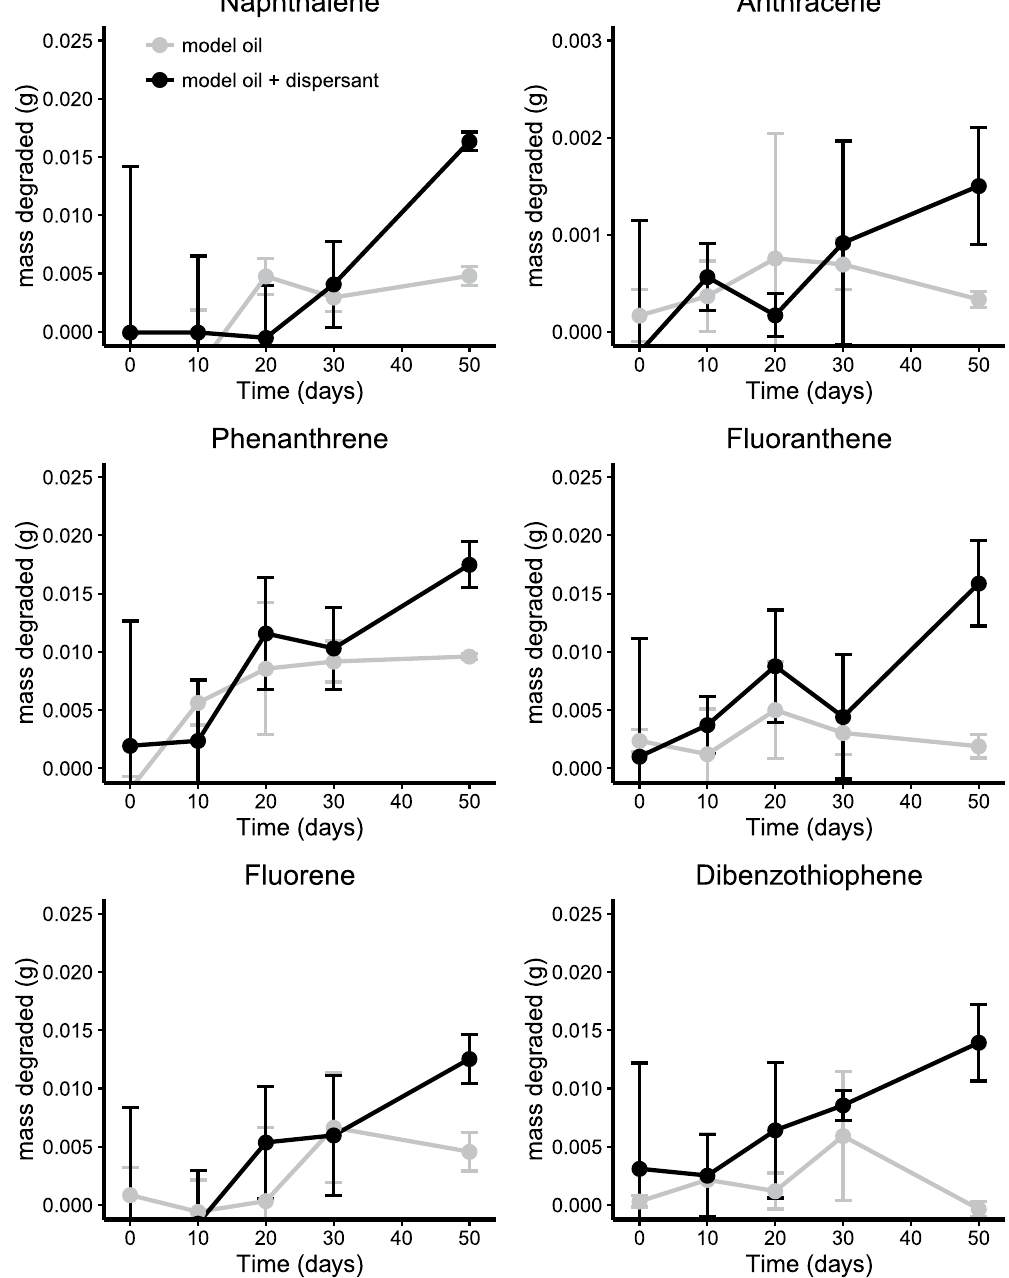
Figure 4. Mass of each PAH degraded during slurry incubations in FSC1000 at 0 °C. Error bars are standard deviation, n = 3. Black lines are model oil and grey are model oil +